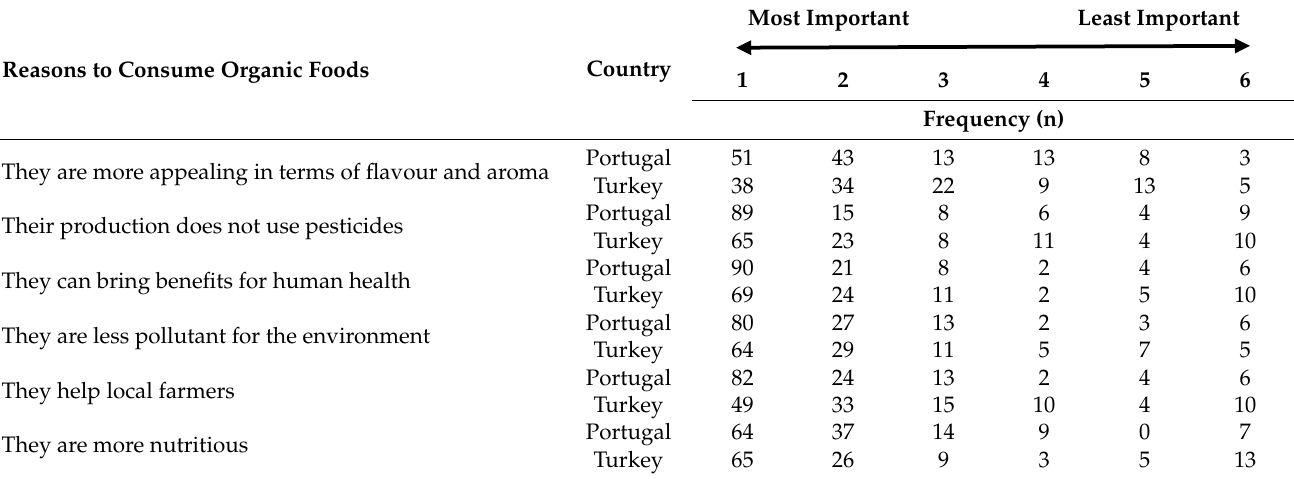
Table 3. Motivations to consume organic foods (scale from 1 = most important to 6 = least important).